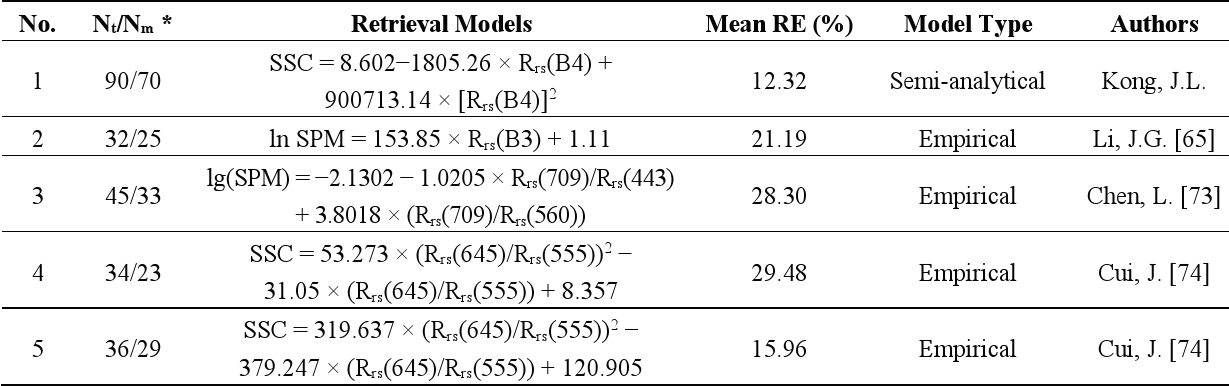
Table 6. The summary of comparing the accuracy of the proposed semi-analytical model with previous empirical models in the study